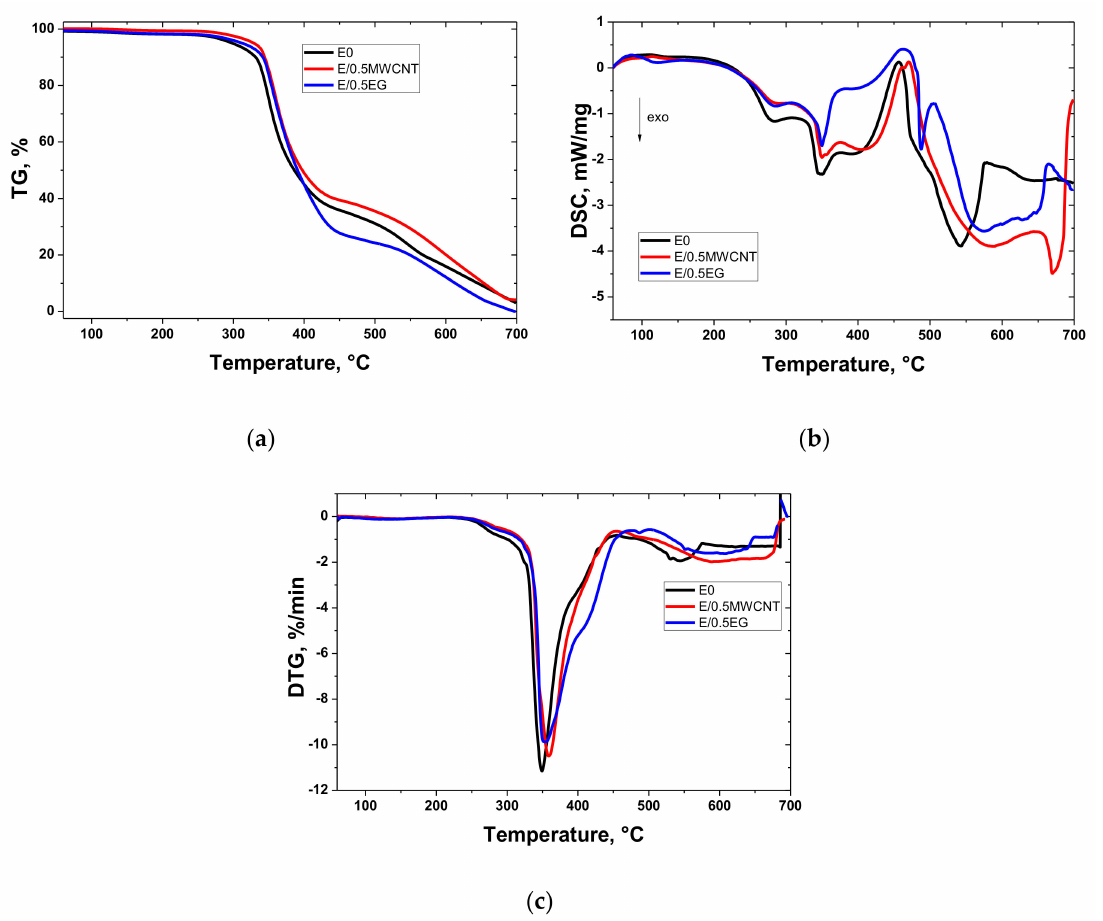
Figure 4. Thermal degradation curves of epoxy composite samples E0, E / 0.5MWCNT, E / 0.5EG: ( a ) TG, ( b ) di ff erential scanning calorimetry (DSC), and ( c ) derivative thermogravimetry DTG